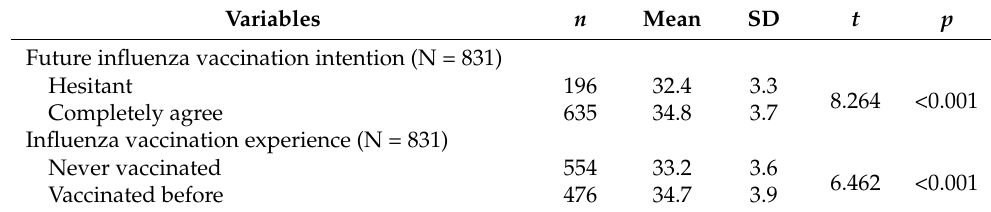
Table 3. Influenza vaccine hesitancy (IVH) scale scores between different groups of subjects.